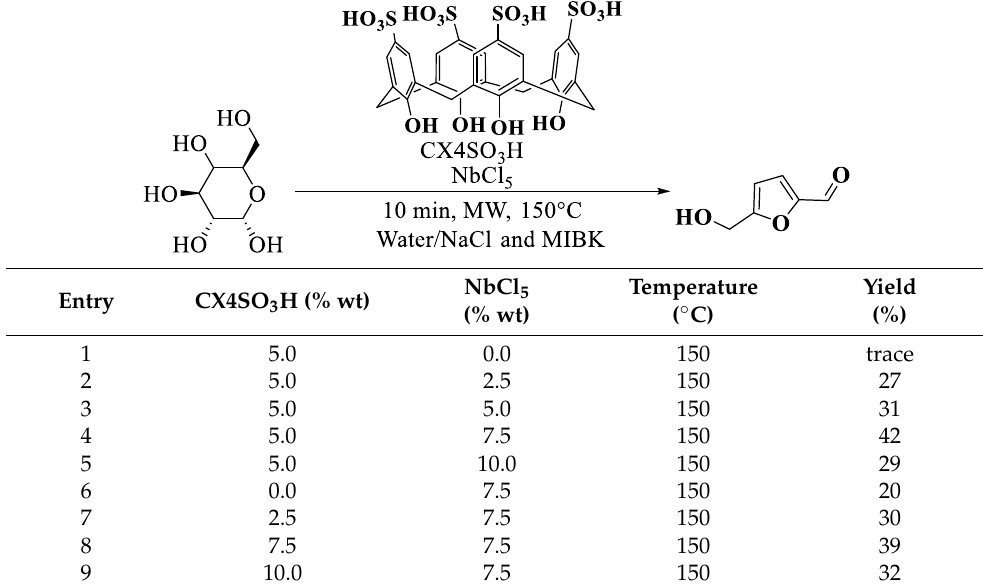
3 H/NbCl 5 consortium